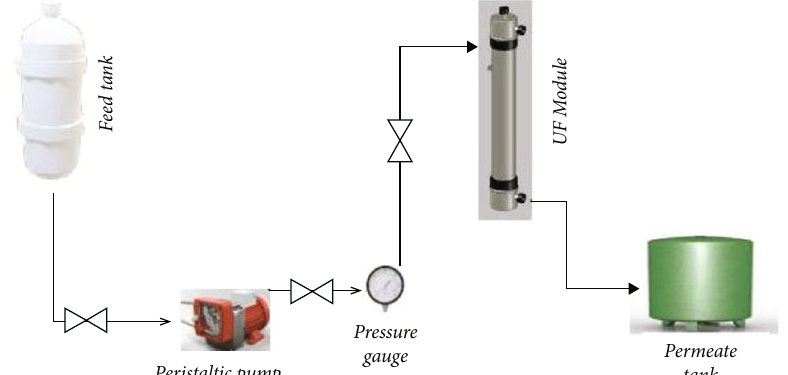
Figure 1: Schematic diagram of ultra fi ltration set-up.